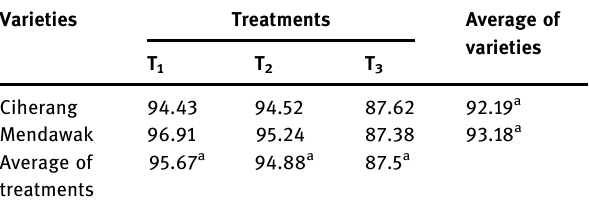
Varieties Treatments Average of